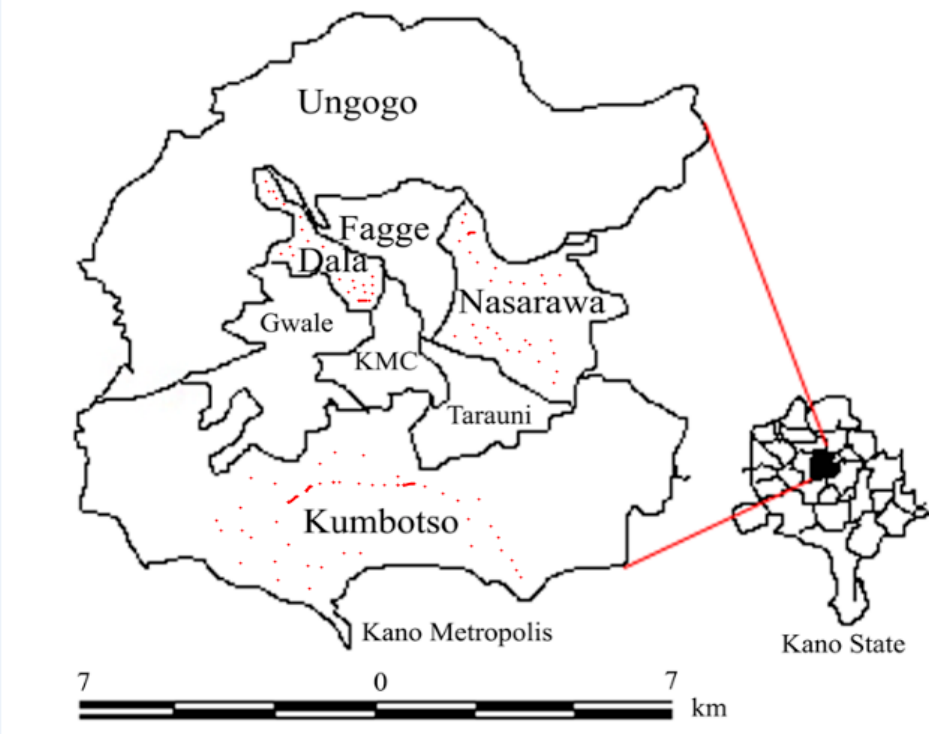
Figure 3. Showing the map of Kano metropolis and the distribution of sample [61].